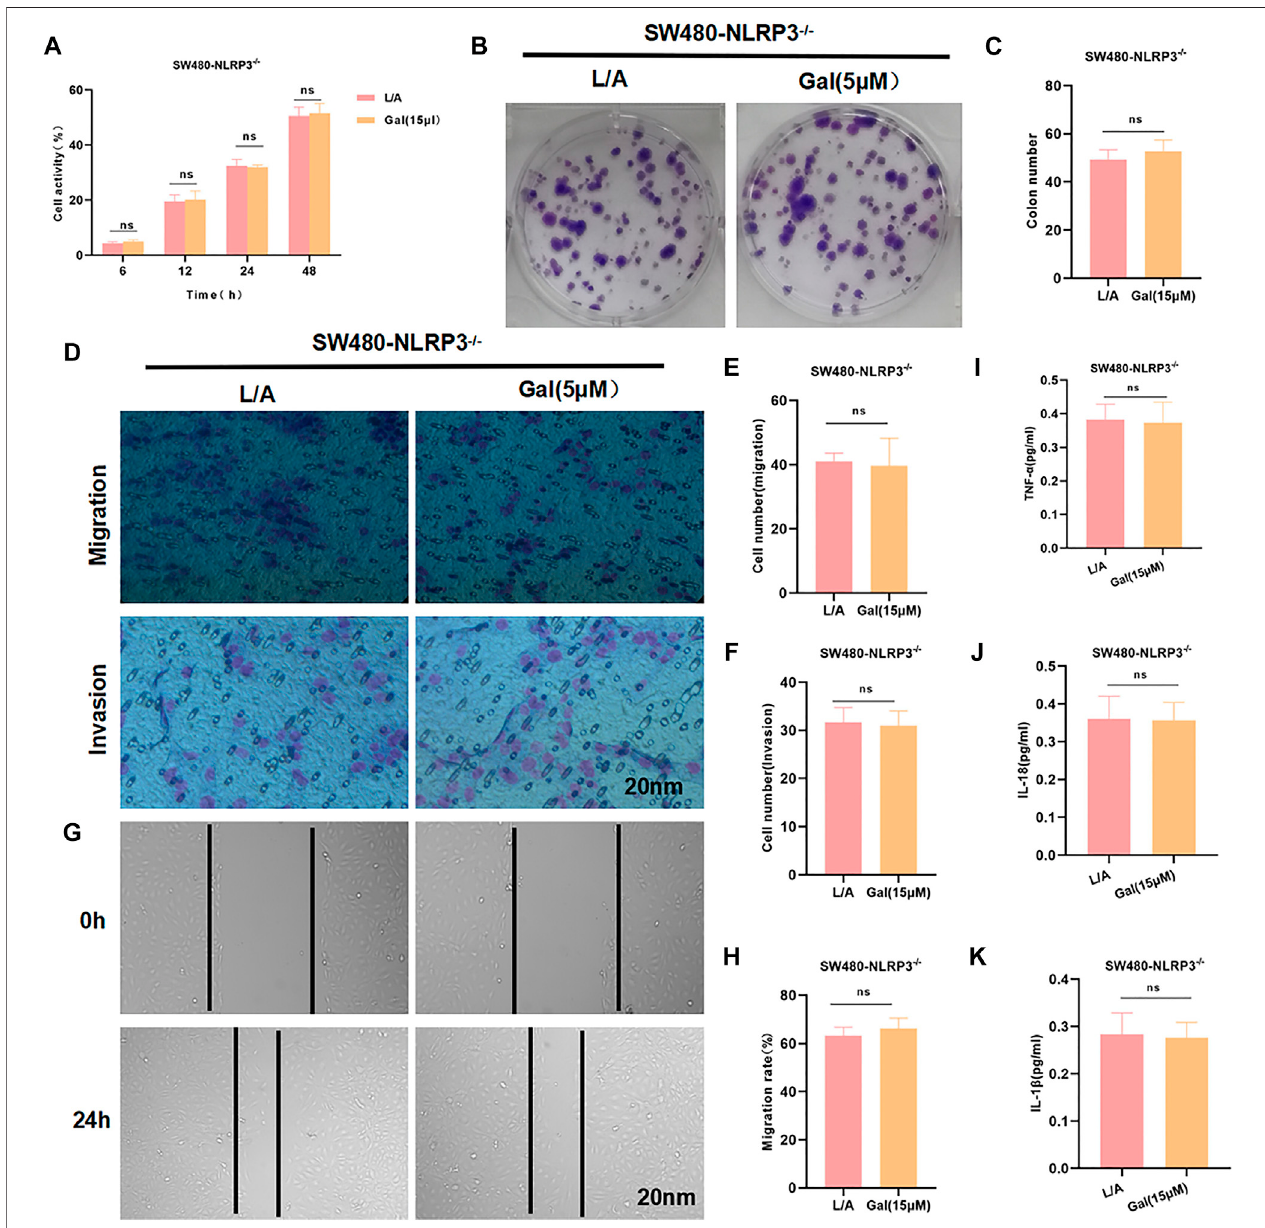
FIGURE 5 | Gallo fl avin cannot further inhibit the malignant behavior of SW480-NLRP3 − / − cells. (A – H) : Gal cannot further inhibit cell viability, colony formation, migration, or invasion ability in SW480-NLRP3 − / − cells. There was no signi fi cantdifference, ns p > 0.05. (I – K) : The detection of in fl ammatory factors revealed that Gal had no signi fi cant effect on the expression of IL-6, TNF- α , or IL-1 β in SW480-NLRP3 − / − cells. There was no difference between the groups, ns p > 0.05.